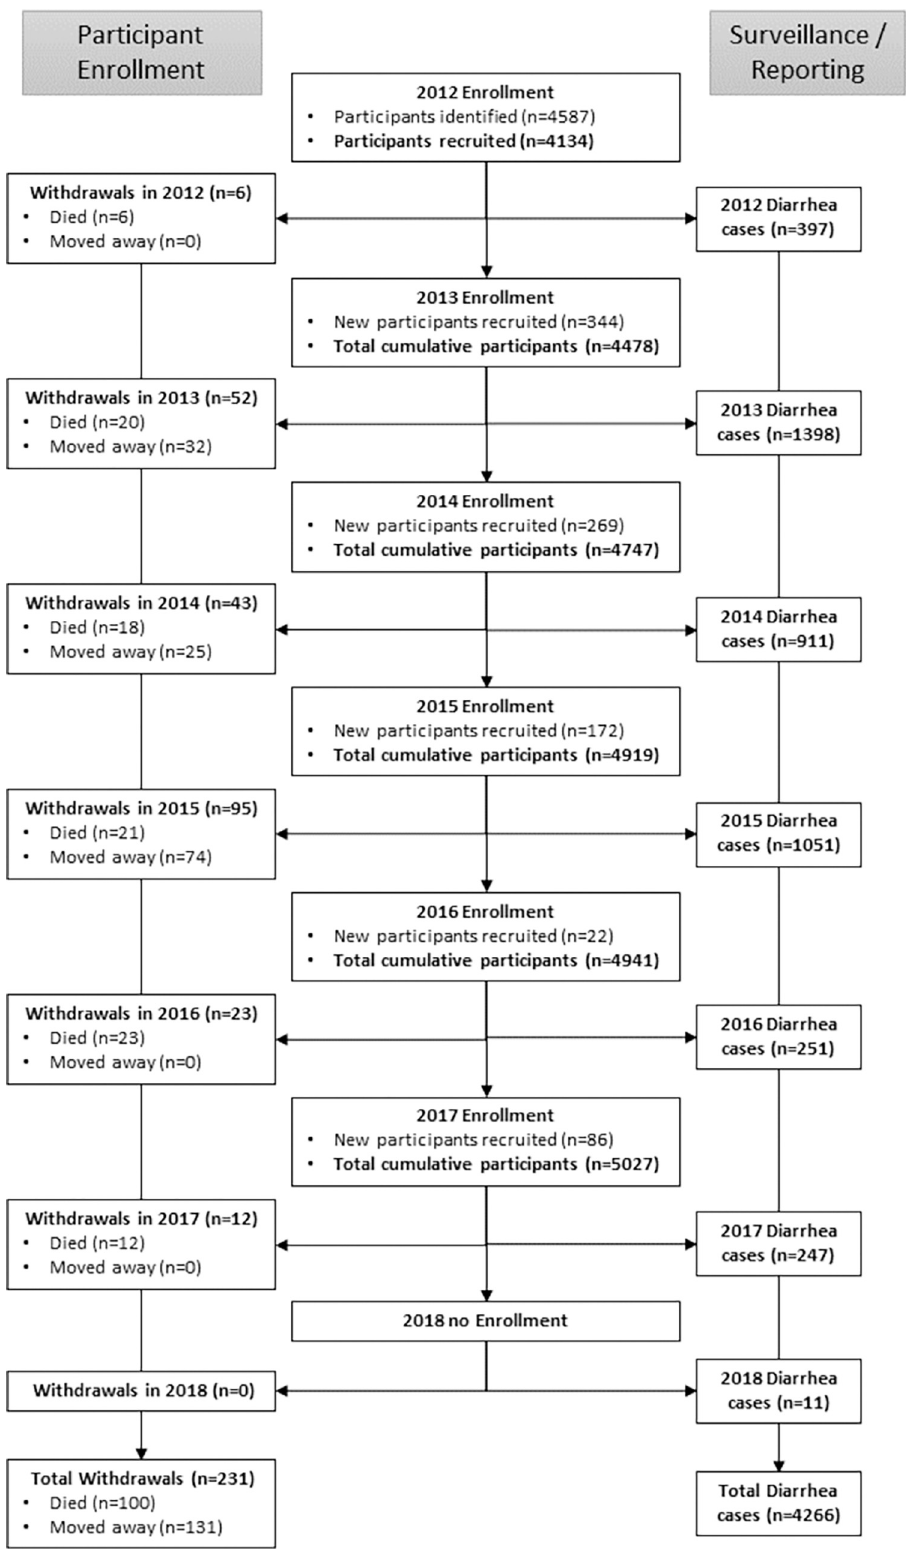
Fig 2. Flow chart illustrating participant enrolment and surveillance reporting workflows throughout the study period.